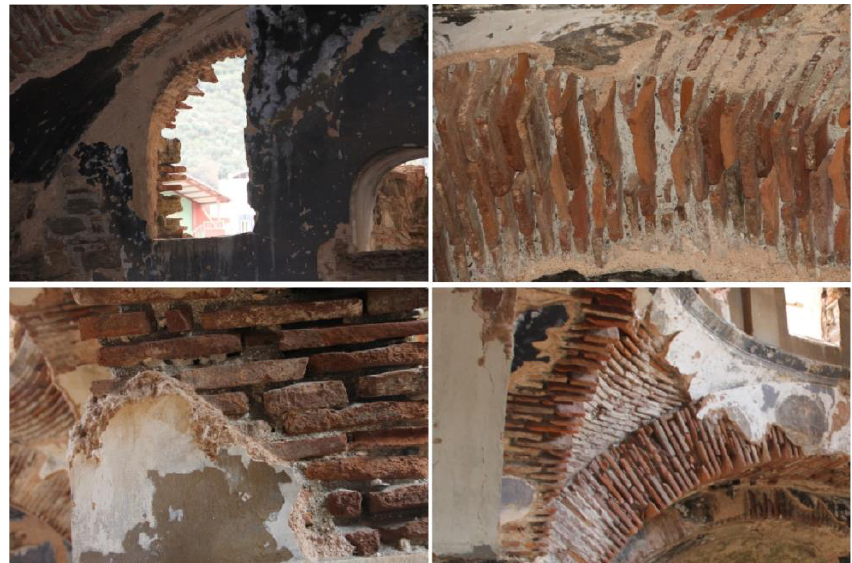
Figure 8. Damages and mortar losses in brick elements.